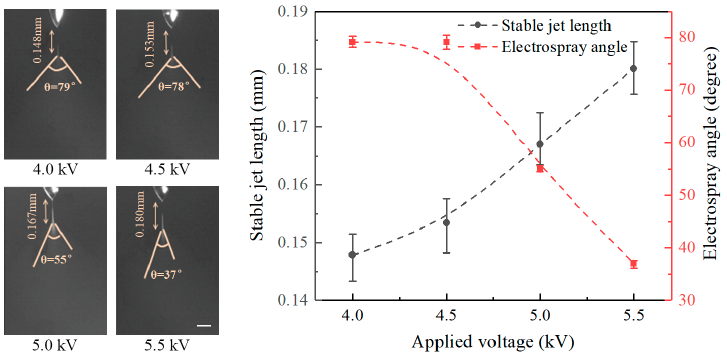
Figure 2. Effect of applied voltage on the stable jet length and electrospray angle. The nozzle-to-substrate distance is 20 mm and the flow rate is 20 μ L/h. Scale bar: 0.1 mm.